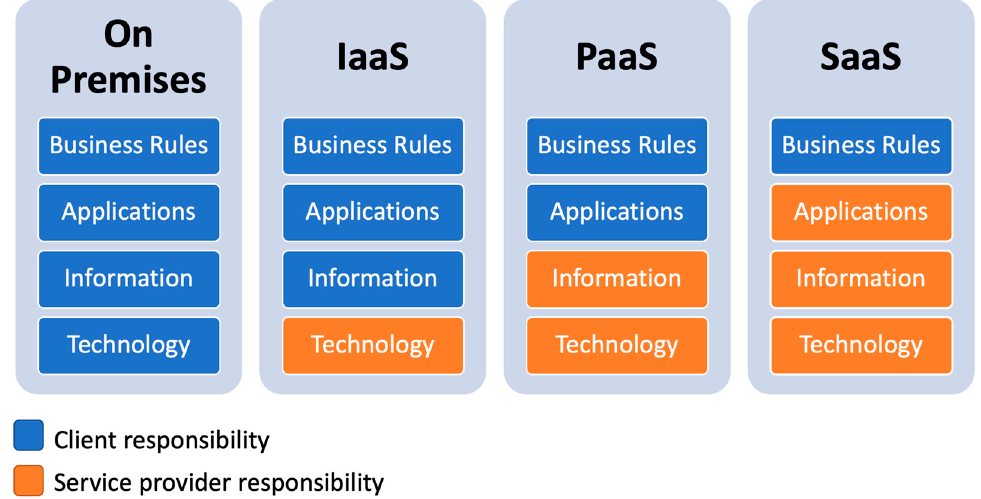
Figure 3. Common depiction of aaS with respect to EA layers (adapted from: https://www.redhat.com/en/topics/cloud-computing/what-is-saas, accessed on 12 January 2023).